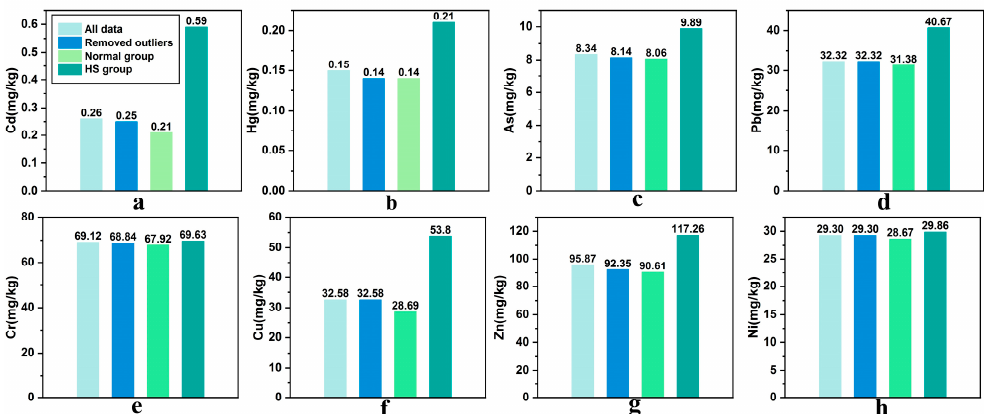
Figure 1. Weighted mean values of ( a ) Cd; ( b ) Hg; ( c ) As; ( d ) Pb; ( e ) Cr; ( f ) Cu; ( g ) Zn; and ( h ) Ni in different groups. Table 1. Regional mean values (mg kg − 1 ) of eight elements in agricultural soil in the Yangtze River Delta